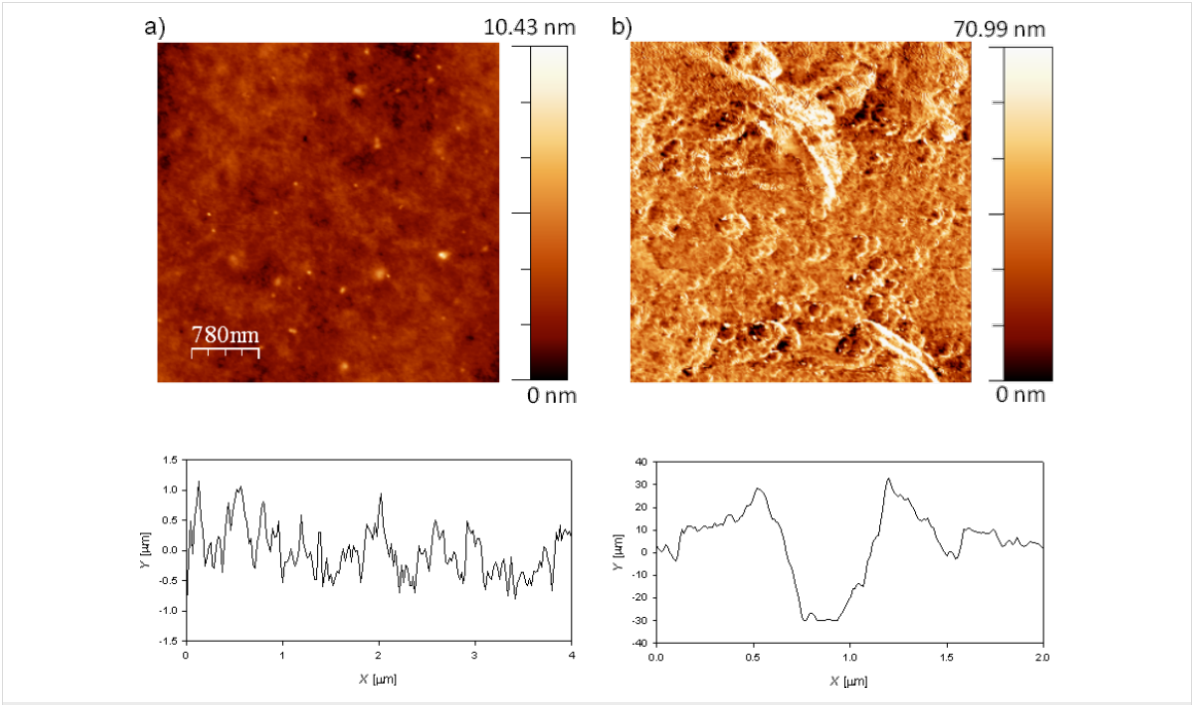
Figure 2: AFM images and height profiles taken along the diagonal of the images for multilayers (PDADMAC + PSS) N built using solutions with two different ionic strength. (a) 0.10 M ( N = 15). (b) 1.00 M ( N = 7).